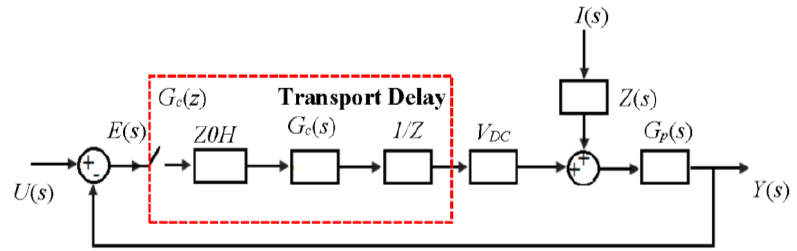
Figure 4. Average value model block diagram of the proposed asymmetrical fault correction technique.